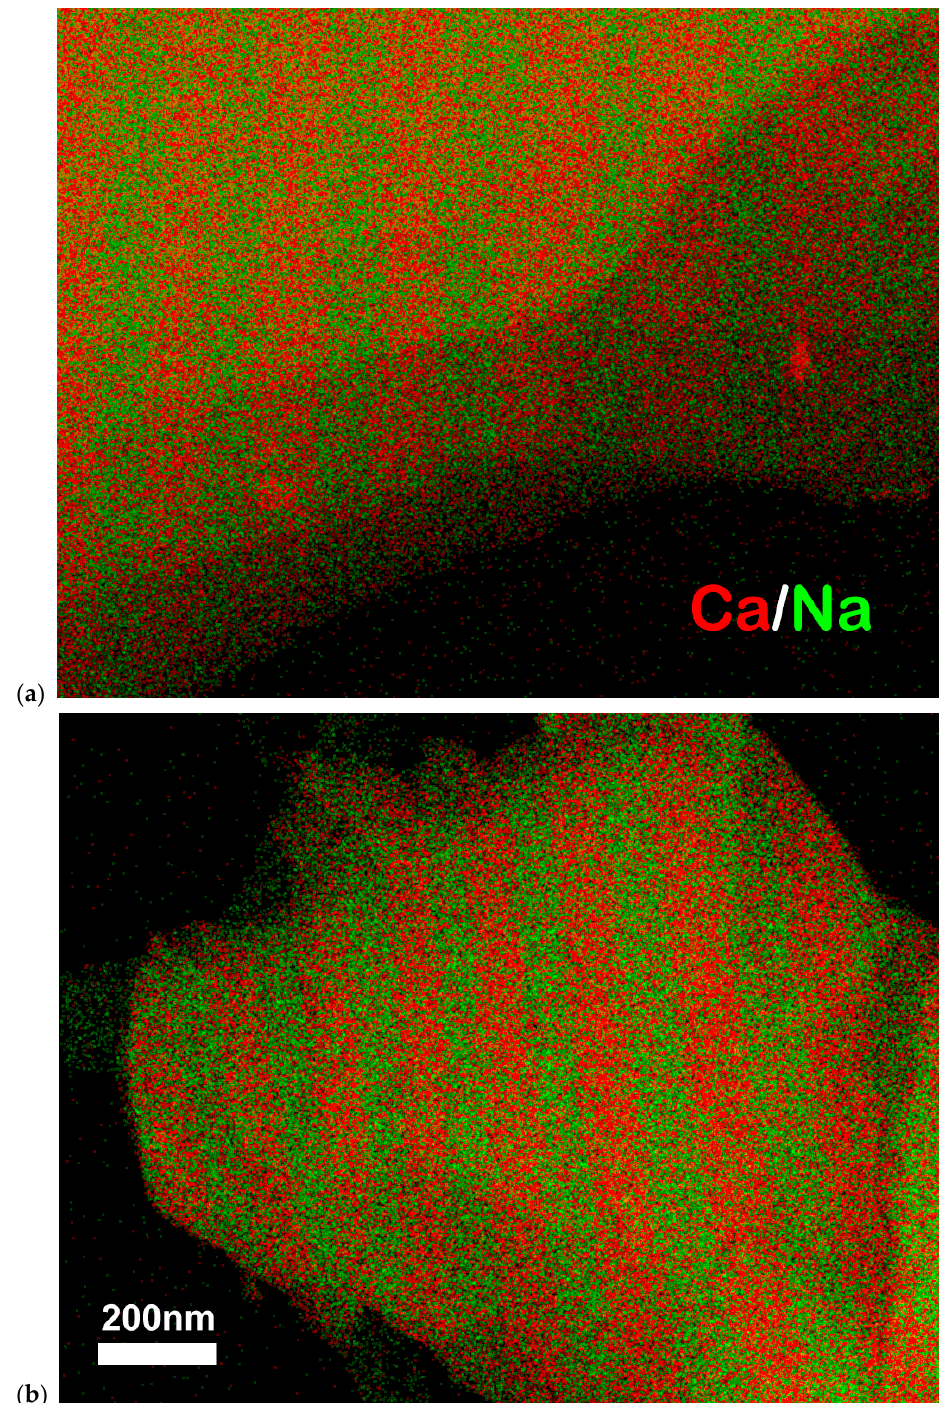
Figure 4. The Ca (red) and Na (green) EDS maps of the red-iridescent ( a ) and blue-iridescent ( b ) areas in sample Gem113. The contrast is higher in the blue-iridescent sample, indicating a larger chemical difference between the Ca-rich and the Na-rich lamellae compared to the red-iridescent sample. The magnification for both images is same.